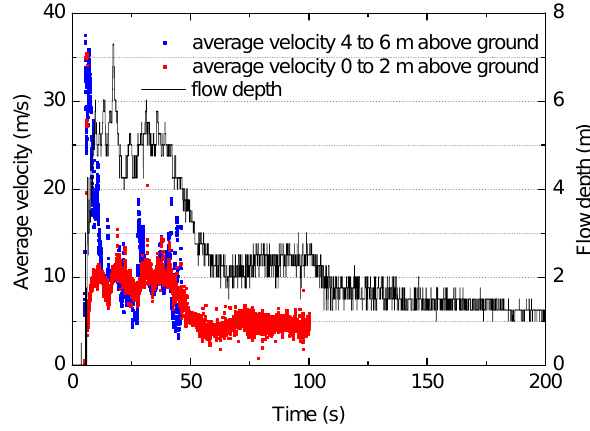
Fig. 3. Avalanche 1 occurred on 30 December 2009 at 13:30. The avalanche path and deposition zone is indicated (solid red line). View is from the shelter. The photo was taken a few days later (photo source: F. Dufour).